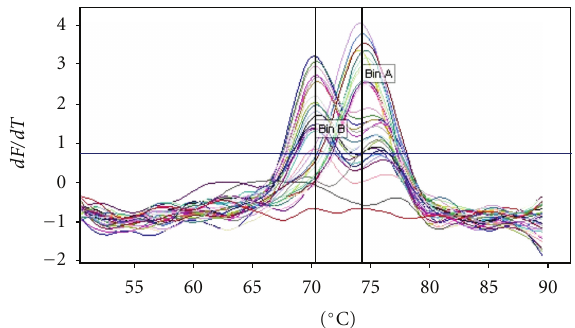
Figure 1: real time-PCR results showing two distinct peaks ( T m ) for wild and mutant rpoB gene. Melt data for melt